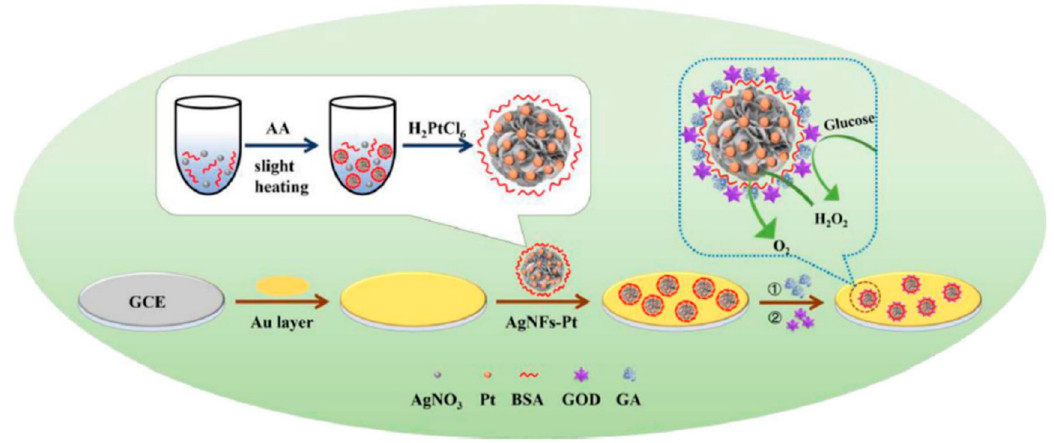
Figure 15. Fabrication of an ECB for the simultaneous detection of glucose and H 2 O 2 . The sensor utilized an Ag nanoflower and PtNPs (AgNFs-Pt) along with enzymes to be able to detect two analytes simultaneously [153]. Reprinted with permission from [153], Copyright © 2020 Published by ECS. AA: L-ascorbic acid.